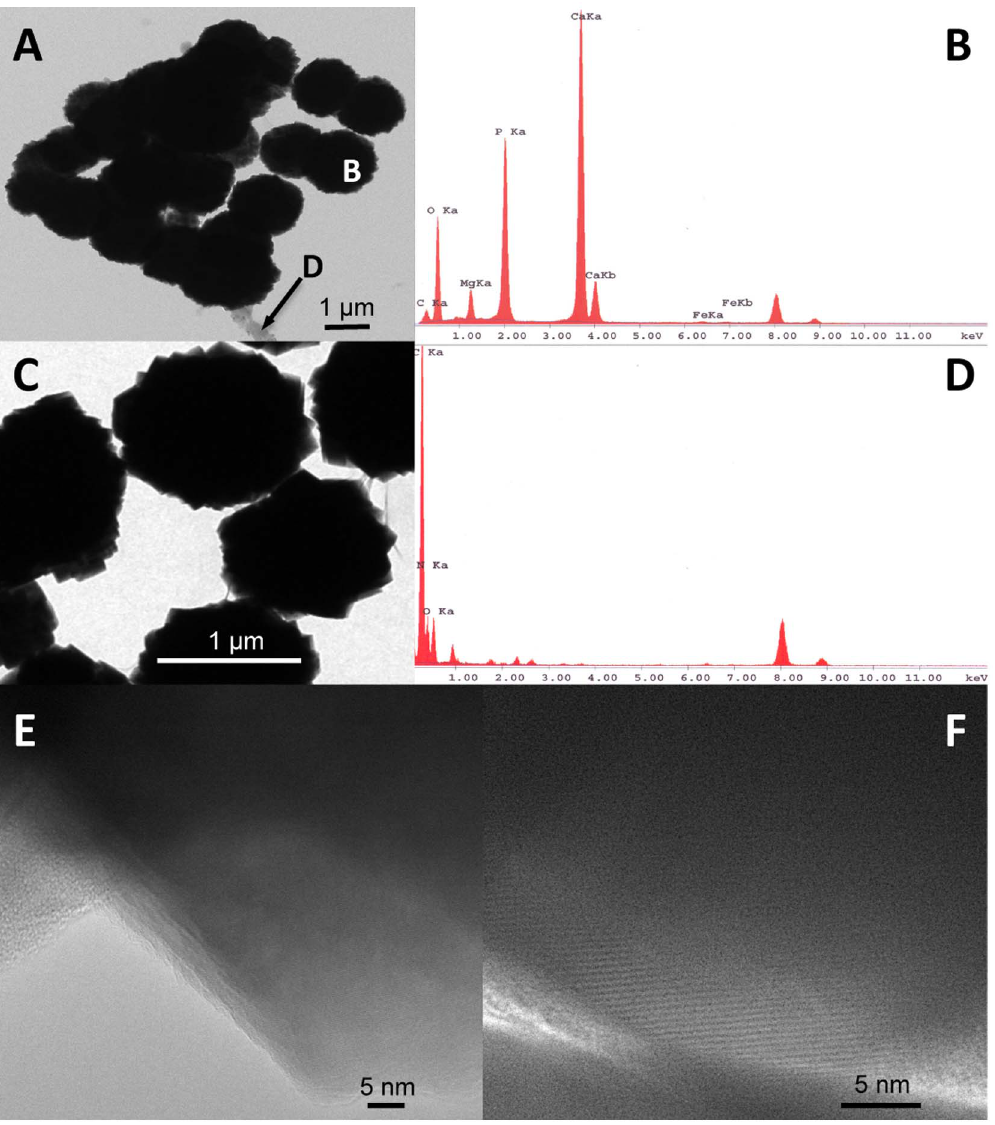
Figure 8. Images (A, C) and corresponding TEM-EDS analysis (B, D) of two areas in a whole-mount sample recovered after 30 days from the culture in the DSMZ medium. (C) Magnification of the area in (A) showing biofilm covering and binding the granules, (B) Spectrum from the granule labelled B. (D) Spectrum from the organic material labelled D. (E, F) HR-TEM images of the granules’ edges showing lattice fringes.